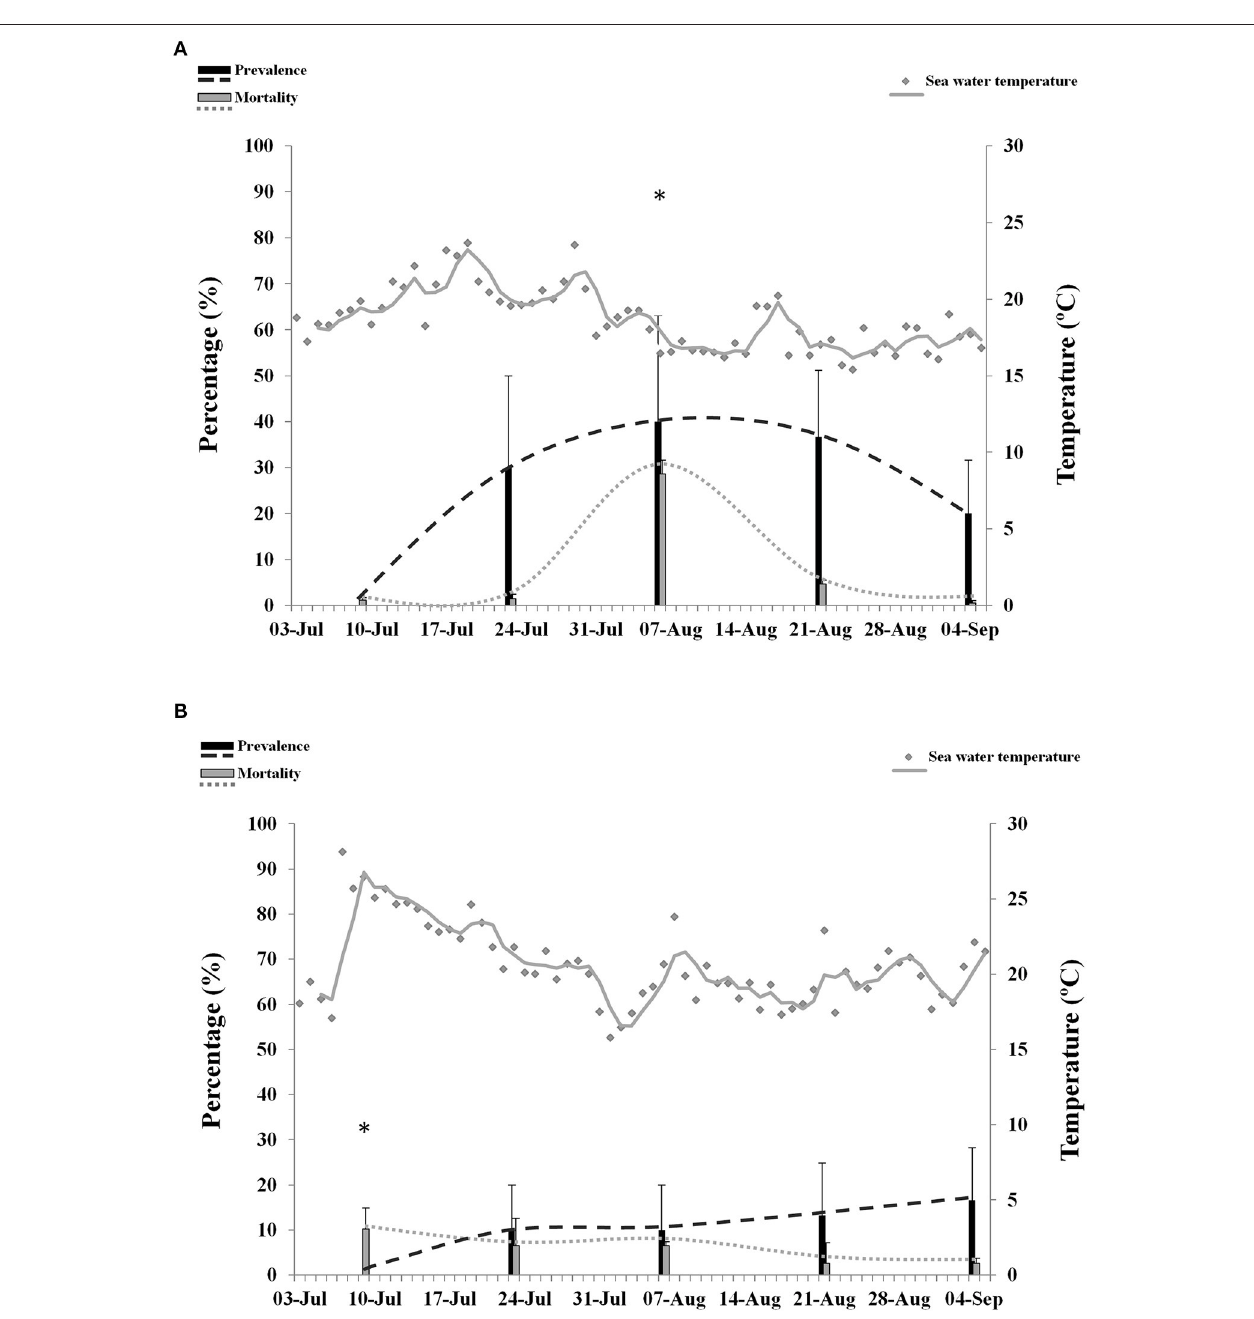
FIGURE 3 | Percentage of mortality and prevalence of OsHV-1 in juveniles collected from Site B (A) and Site C (B) . Maximum sea water temperature on each site is represented with gray dots and gray trend line. Asterisks show significantly higher mortality ( n = 3, p ≤ 0.05).